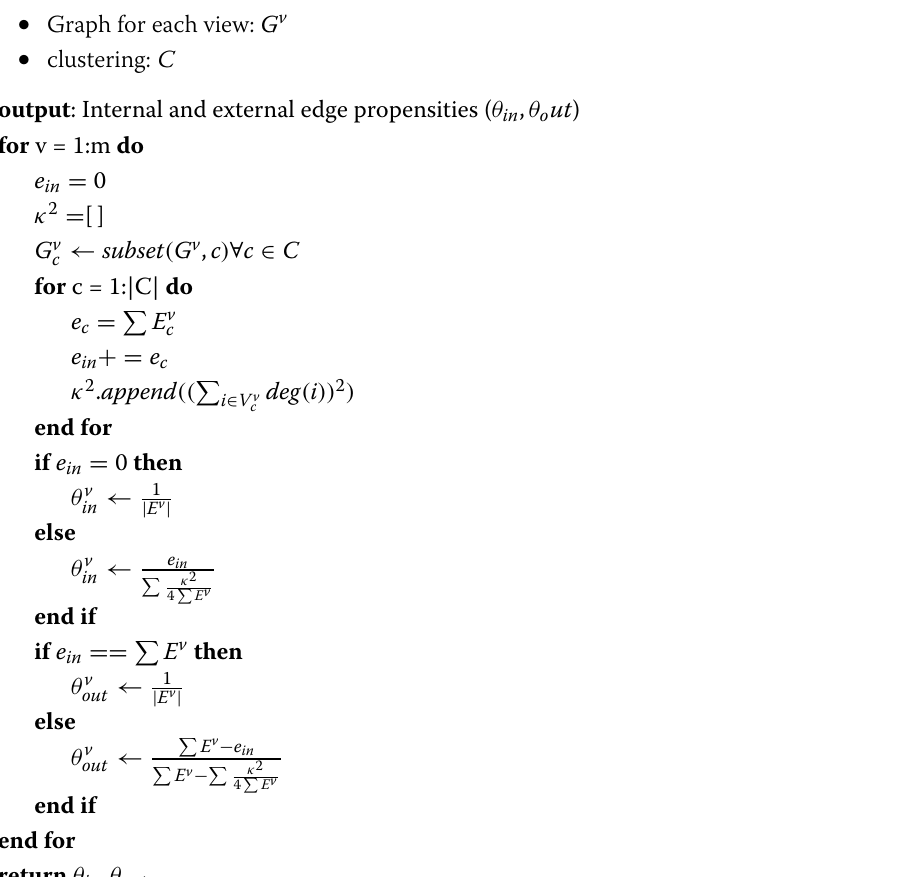
Algorithm 2 Calculation of Edge